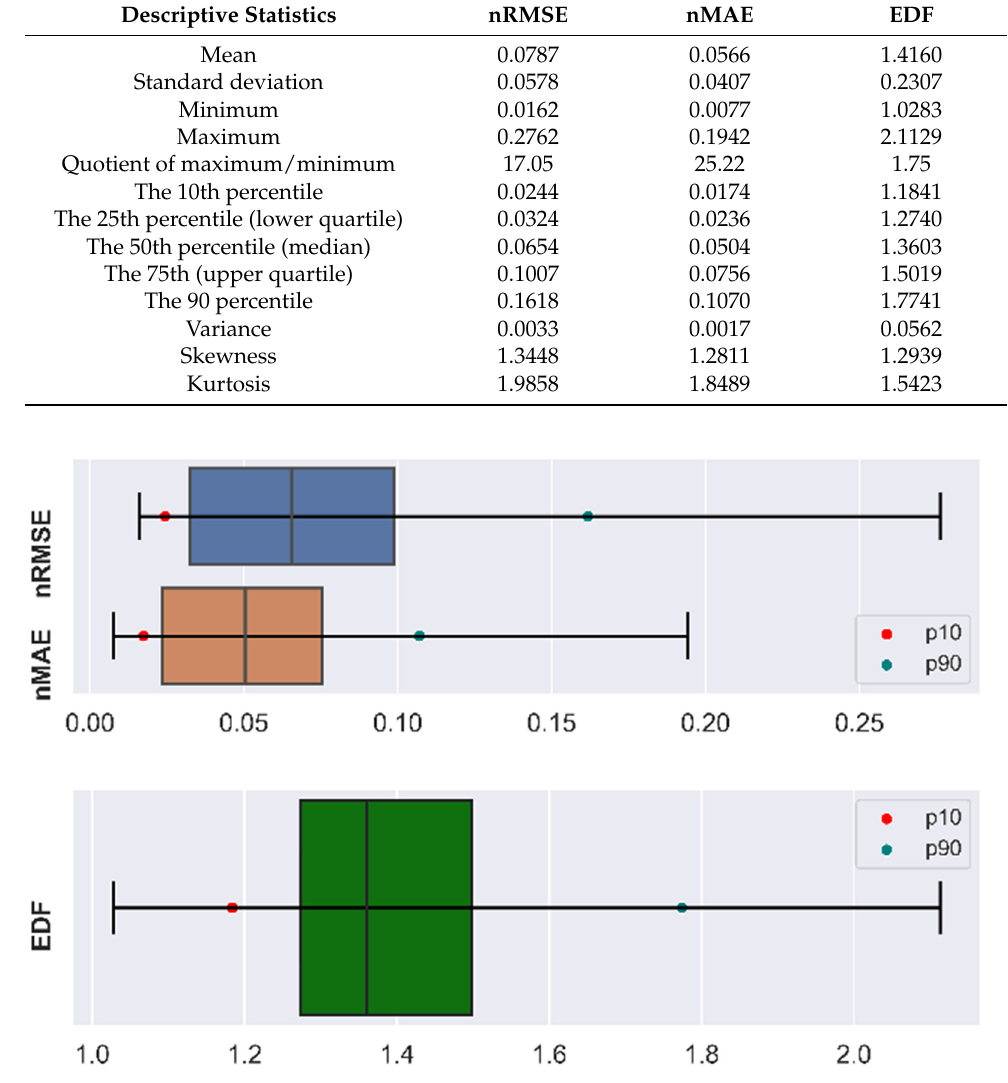
Table 8. Descriptive statistics of errors and error quotients.